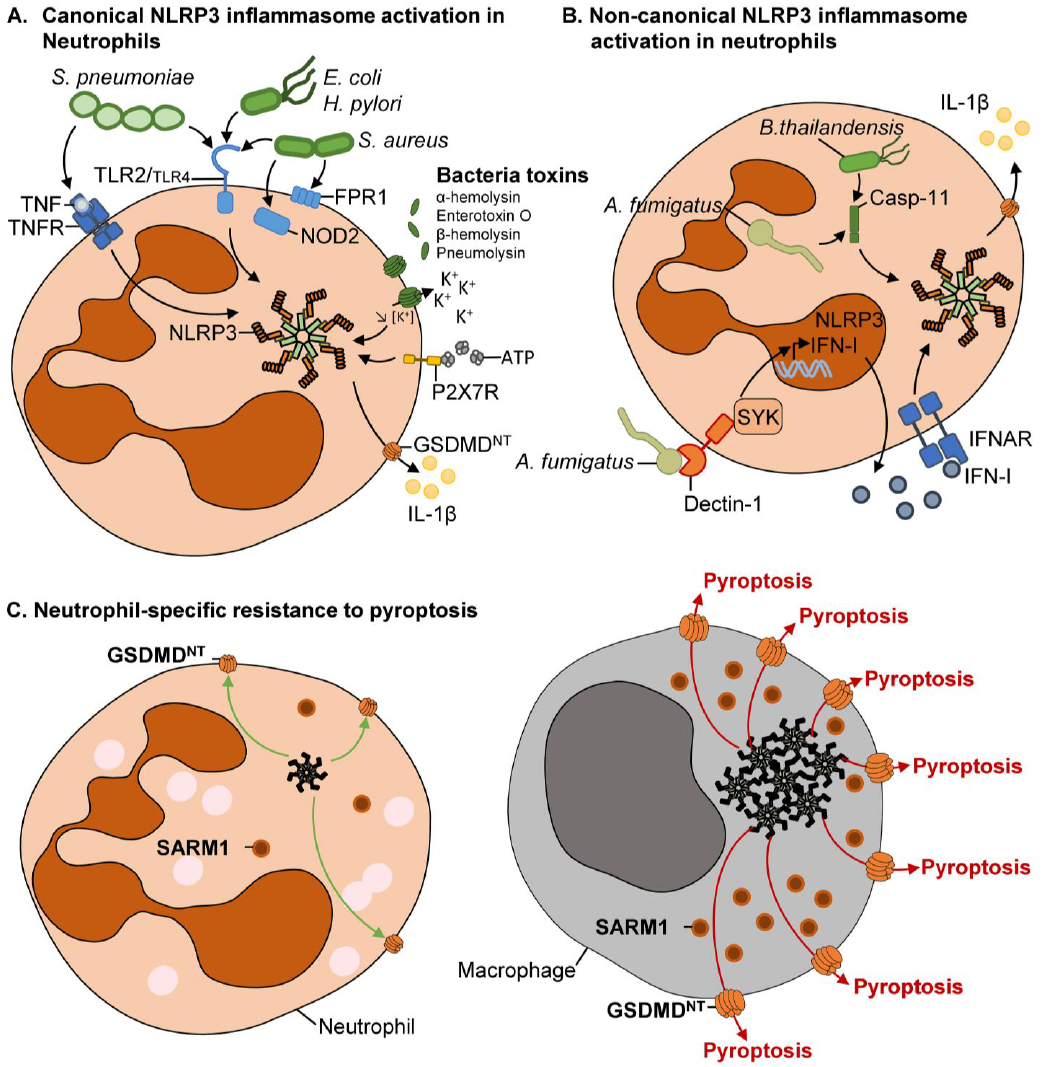
Figure 2. Mechanism NLRP3 inflammasome activation in neutrophils. ( A ). Canonical NLRP3 in- flammasome activation in neutrophils. Extracellular bacteria are mainly sensed by Toll-like receptor 2 (TLR2) and, in some cases, TLR4, Nucleotide-binding oligomerization domain-containing protein